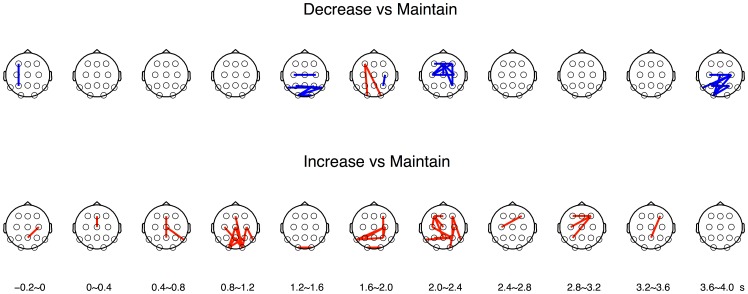
Differences of degree in PLV pairs between cognitive reappraisal conditions.The top panel shows the comparison between the decrease and maintain conditions (red: maintain>decrease; blue: maintain<decrease). The bottom panel depicts the comparison of the degree of PLV in all possible pairs between the increase and maintain conditions (red: increase>maintain; blue: increase<maintain). Significance level is p<0.01. Bottom labels represent the time windows based on visual stimulus onset.